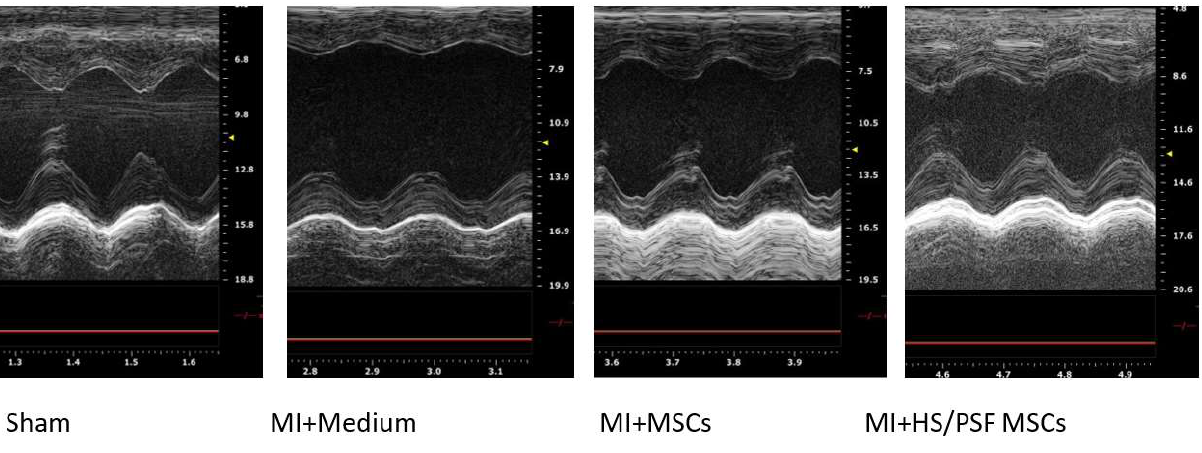
SV/BW ( µ L/g) CO (mL/min) (mL/min/g)